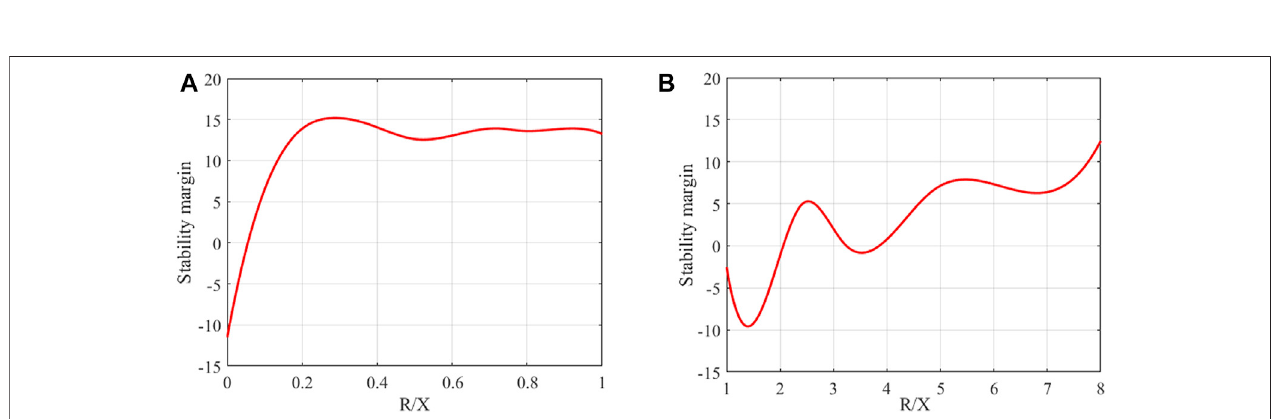
FIGURE 8 | Root locus with the change of the line impedance (PV node): (A) R/X ratio is smaller than 1, (B) R/X ratio is larger than 1.